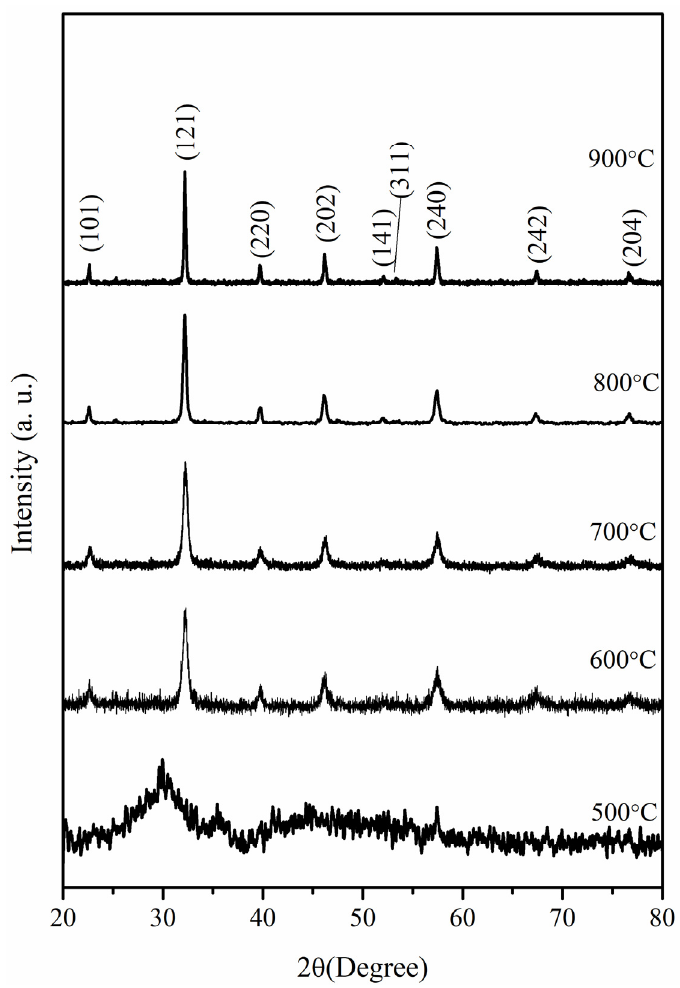
Figure 10. XRD patterns of Pr-LaFeO 3 after calcination at different temperatures.